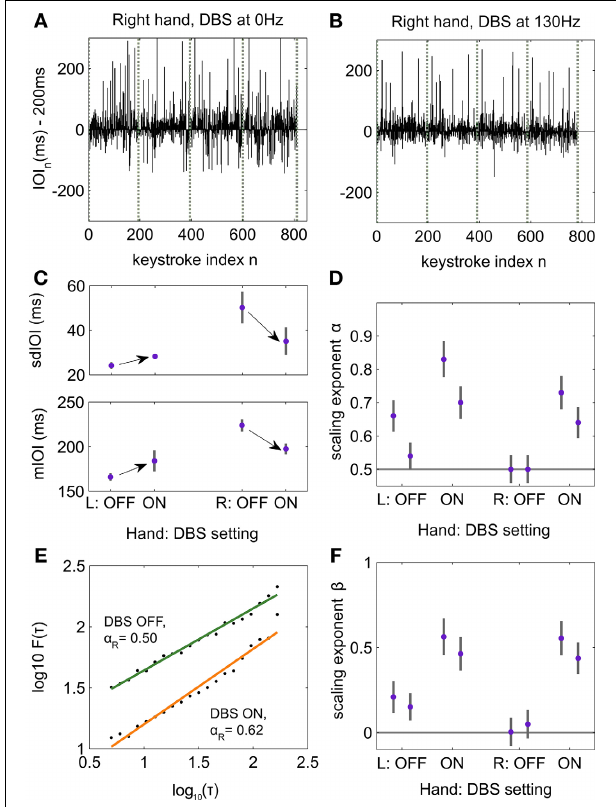
FIGURE 4 | Influence of deep brain stimulation (DBS) on the structure of temporal correlations during piano performance. (A) Time series of deviations in inter-onset-interval (IOI, ms) values during performance with the tremor-affected right hand and without DBS. Vertical lines denote boundaries between trials corresponding to renditions of the same sequence type. The IOI fluctuates around the nominal IOI of 200ms. (B) Same for performance with the tremor-affected hand during DBS ON (clinical settings at 130Hz). (C) Average and SE (gray lines) values for mIOI and timing accuracy (sdIOI) are displayed for each hand and DBS setting separately. Assessment of the sdIOI and mIOI across trials with a two-factorial design with factors hand (L/R) and DBS (ON, OFF) demonstrated a significant interaction ( p = 0 . 0001). Hence, whereas DBS ON improved timing parameters in the affected hand, it deteriorated timing performance in the less affected hand. Arrows denote the significant changes between ON and OFF DBS for each timing measure as assessed in a post-hoc analysis with pairwise paired permutation tests for each factor separately (Right hand: p = 0 . 0078 for changes in mIOI and sdIOI; Left hand: p = 0 . 03 for changes in mIOI, trend of significance for changes in sdIOI, p = 0 . 08). (D) First-order DFA scaling exponents α for each hand and DBS setting, separately for each of the two recorded conditions with DBS ON, and two recorded conditions with DBS OFF. The gray bars accompanying each value indicate the intrinsic error in the estimation of scaling exponents with DFA. DBS OFF led to uncorrelated fluctuations for the tremor-dominant hand ( α ∼ 0.5). In the less affected left hand DBS ON enhanced the degree of LRTC exhibited in the time series of temporal fluctuations. Note the replicability of the scaling exponents across the two conditions of each kind. (E) Log–log plot of the fluctuation function F (τ) against increasing time scales τ spanning 5–200 keystrokes corresponding with performance of the tremor-dominant right hand. Under DBS ON, DFA demonstrated power-law scaling behavior in the time series with scaling exponents in the LRTC range (0.5 < α < 1; data fitted to an orange line). By contrast, without DBS performance with the affected hand